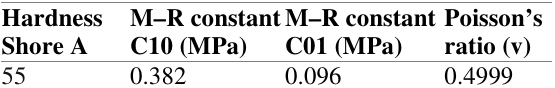
Plastic strain ratios and anisotropic yield stress ratios.